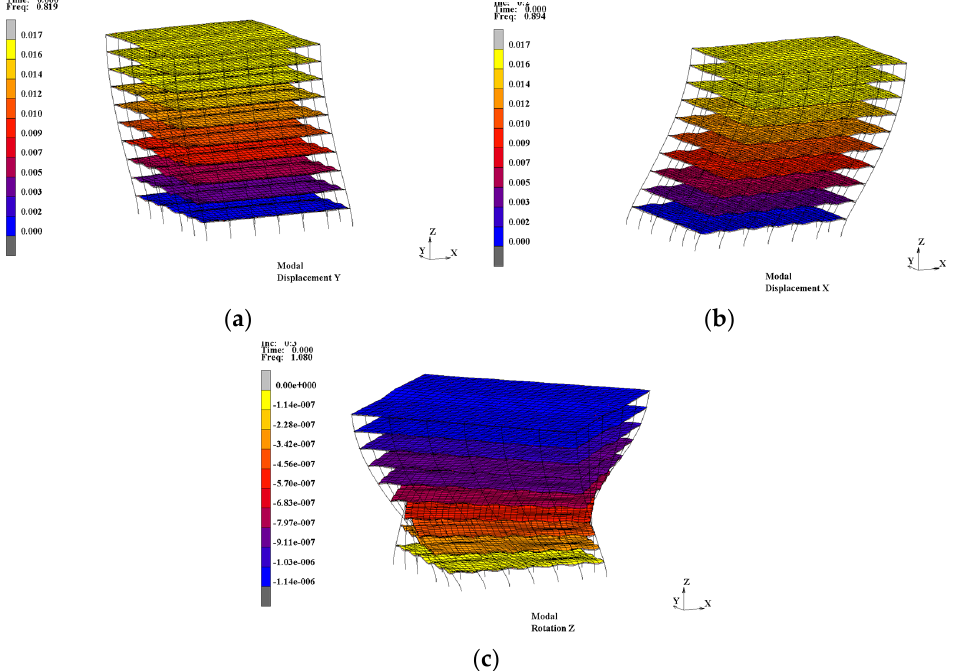
Figure 6. Mode characteristic of the first three modes (full-span URSP connectors): ( a ) 1st mode; ( b ) 2nd mode; ( c ) 3rd mode.